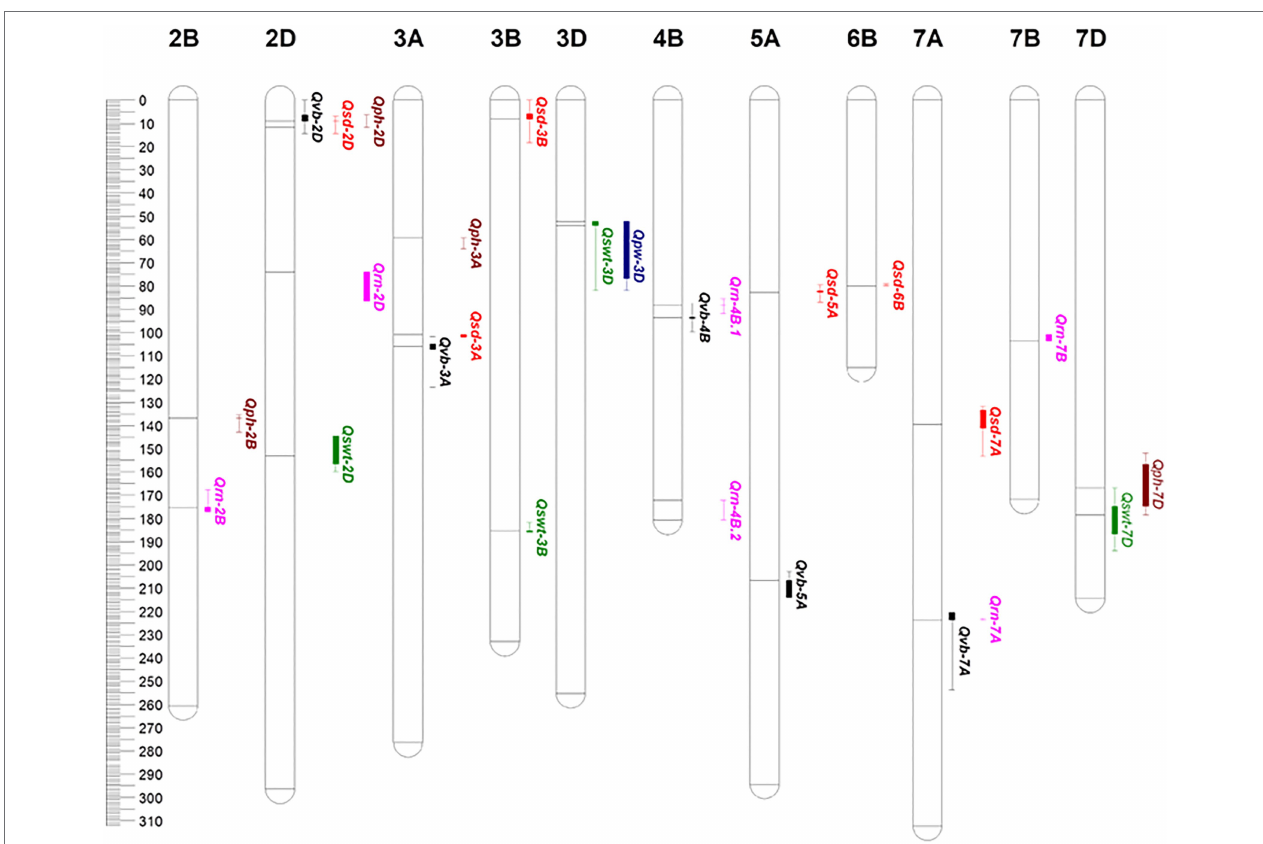
FIGURE 5 | QTL identified for stem- and yield-related traits. The solid line near each QTL within each chromosome indicate the nearest marker of individual QTL, respectively. vb: number of big vascular bundle; sd: stem diameter; swt: stem wall thickness; rn: the number of the spikelet; pw: panicle weight; ph: plant height. Black color for VB; red color for SD; green color for SWT; purple color for RN; blue color for PW; brown color for